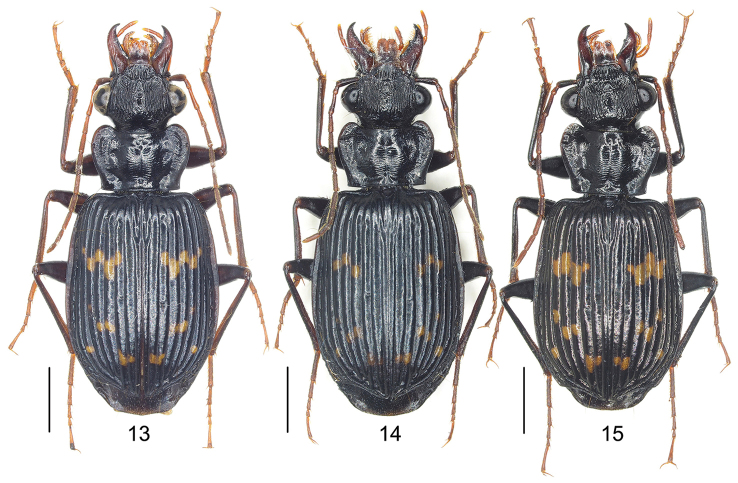
Habitus 13
P.
obscuratus sp. n., holotype, Guizhou (Fanjingshan), male 14
P.
obscuratus sp. n., paratype, Guizhou (Fanjingshan), female 15
P.
obtusipennis Fedorenko, Yunnan (Pianma), male. Scale bars: 2 mm.